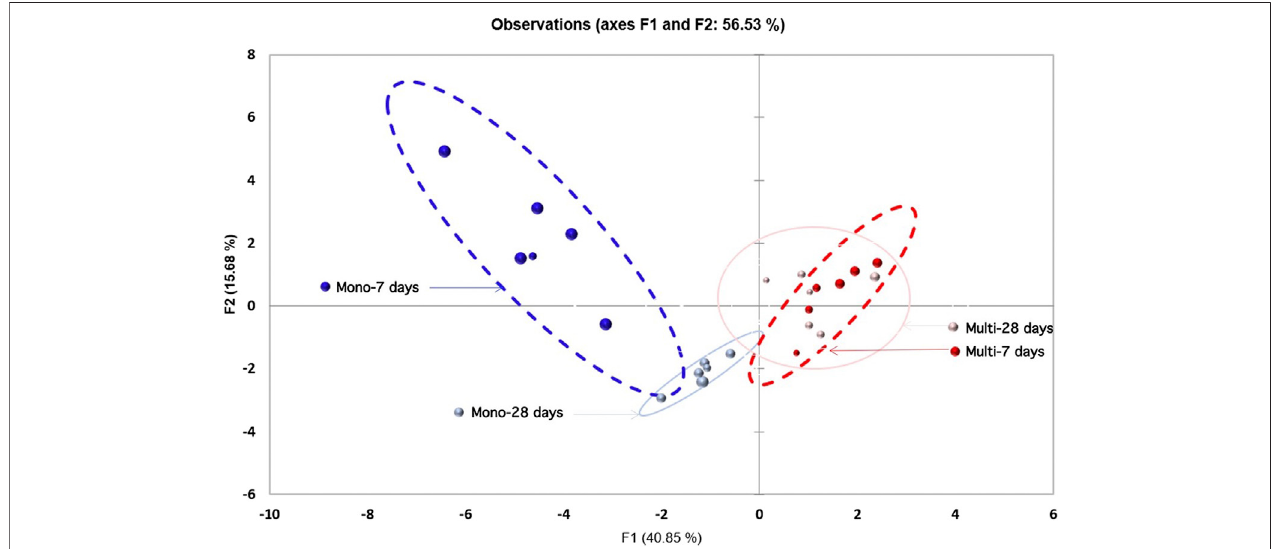
FIGURE 1 | Loading plot (F1, F2) gathering 24 observations clustered for to the contamination scenarios. Red: multiple dosing (multi) of CeO 2 ENMs. Blue: single pulse (mono) of CeO 2 ENMs. Dashed lines: after 7 days of exposure. Full lines: after 28 days of exposure.